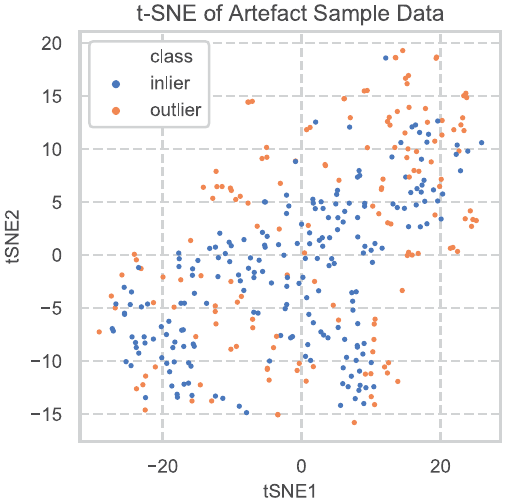
Figure 3. t-SNE plot showing identity of outliers identified by local outlier factor model.